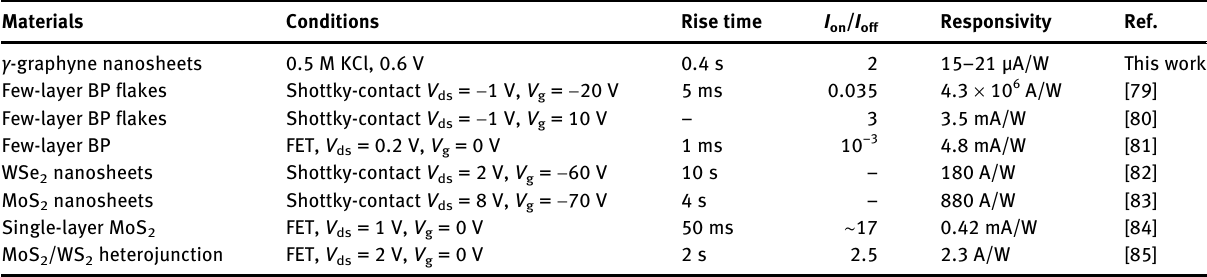
Table  : Contrastive list of several test parameters for the as-prepared graphdiyne photodetector and others.